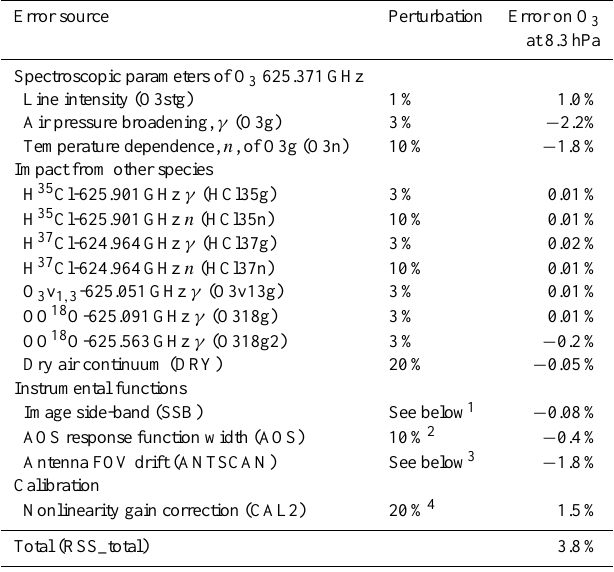
Fig. 3. Estimated systematic errors for O 3 (Band-B) profile from the NICT level-2 v2.1.5. Left panel shows the reference O 3 profiles used for the error estimation. Center and right panels show the estimated error in O 3 retrieval with absolute and relative values, respectively. In thesepanel,thethickblacklinerepresentsthetotalsystematicerrorcalculatedwiththeroot-sum-squareoftheindividualerrorsources. Other notations aretheerrorfromtheuncertainty of; antscan: theantenna FOVdrift,aos: the AOSspectrometer, o318g2, thepressurebroadening parameter γ of Asym − 18 − O 3 at 625.563 GHz, o3g, thepressure broadening parameter γ of O 3 , o3n: the temperature dependence of γ of O 3 ,o3stg: thelineintensityof O 3 . AalsoseeTable3fortheassumed uncertaintiesontheseerrorsources. Theerrorsfromtheuncertainties oftheimage side-band, dry continuum, andother spectroscopic parametersarenot shown inherebecause oftheirrelativelysmall impacts.